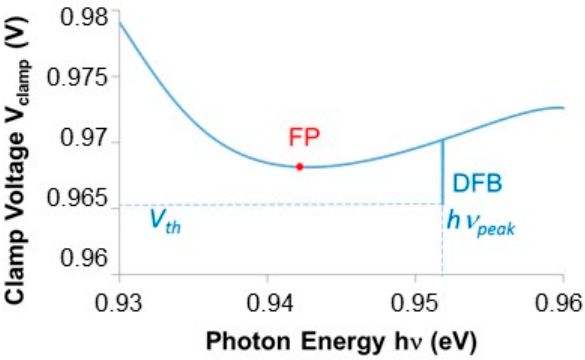
Figure 13. Spectral clamp voltage V clamp , indicating the threshold voltage V th and the peak emission energy h ν peak . The dot labelled FP indicates the values that V th and h ν peak would acquire in the case of no DFB grating .